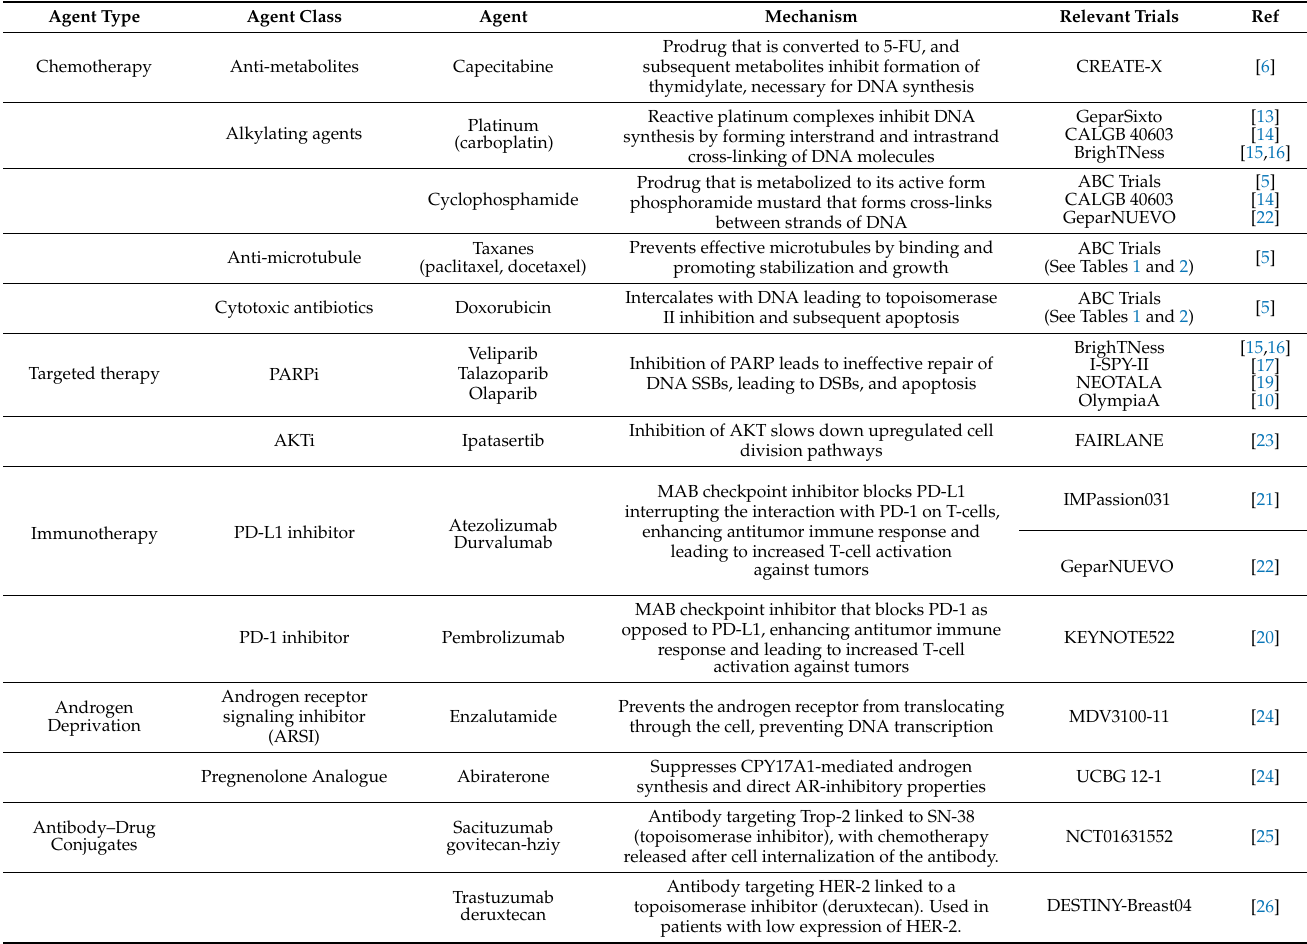
Table 3. Details of agents used in Triple Negative Breast Cancer